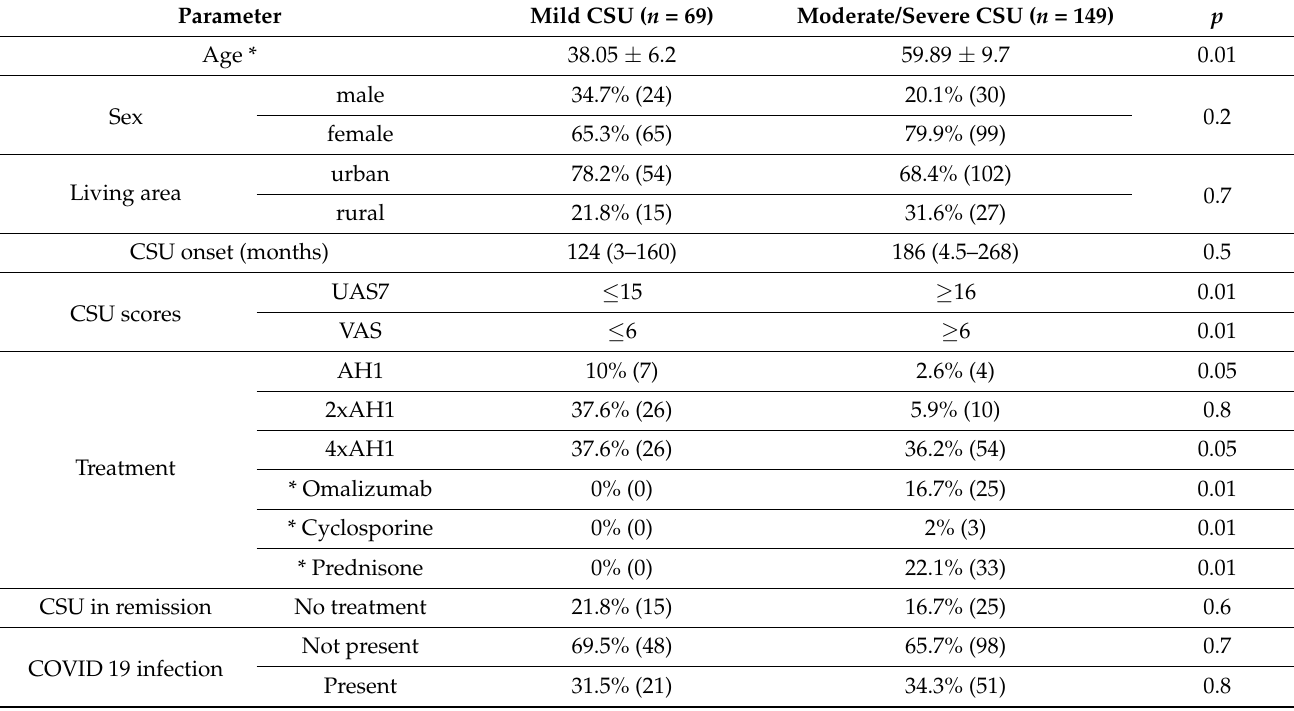
Table 1. Demographic characteristics of the patients in our study